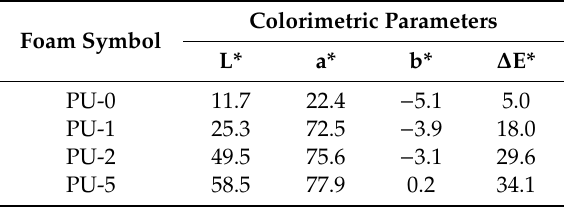
Table 7. Color analysis of PU foams before UV aging. Foam